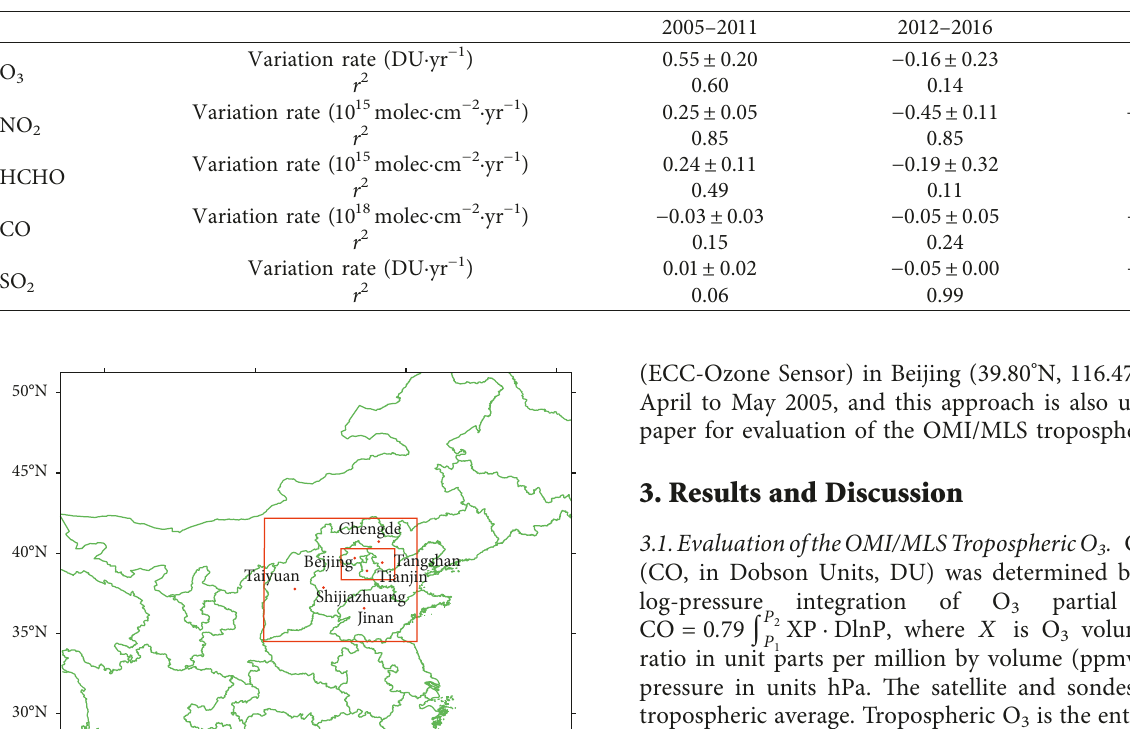
Table 1: Annual variation rates of O 3 and other air pollutants from satellite observations over three periods (2005–2011, 2012–2016, and 2005–2016) in the NCP.